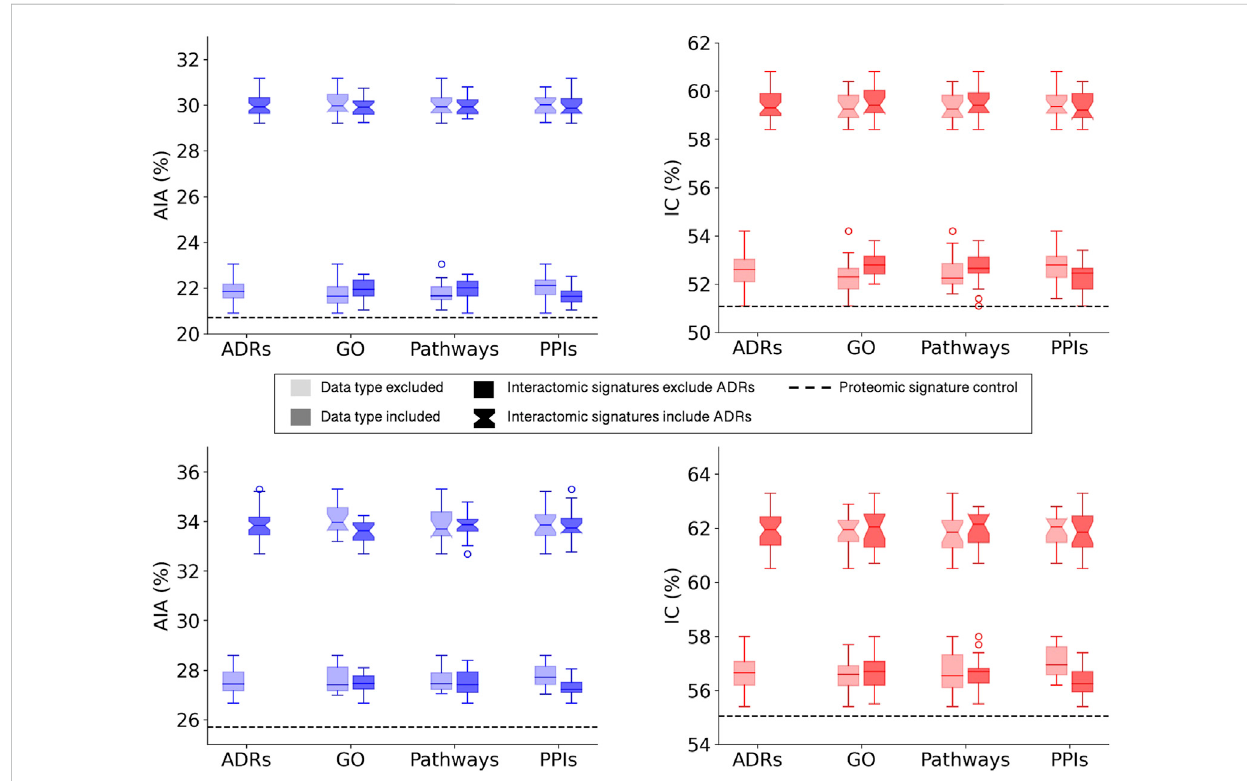
FIGURE 2 Benchmarking performance of CANDO interactomic signatures with various biomedical data. The difference in benchmarking performance when including or excluding certain biomedical data sources in the multiscale networks, namely, adverse drug reactions (ADRs), Gene Ontology (GO) annotations,proteinpathways,andprotein-proteininteractions(PPIs),isdepictedforthefulldruglibrary(top).Bothaverageindicationaccuracy(AIA)and indication coverage(IC)followedthesameoveralltrendinwhichnetworksthatincludedADRs(notchedboxplots)farexceededtheperformanceof networksthatexcludedADRs(squareboxplots).Thistrendwasnotobservedfortheremainingdatatypesinregardstotheirinclusion(darker)orexclusion (lighter) from the networks. However, all interactomic signatures far exceeded the proteomic signatures control (dashed black line) in performance regardless of the presence of ADRs, indicating the multiscale networks were still accurately capturing drug behavior. The above analysis was repeated withasublibraryof1,047drugsthathadatleastoneADRassociatedfromSIDERandOFFSIDES(bottom).Similarresultswereobservedwiththissublibrary for both average indication accuracy (left) and indication coverage (right), suggesting it is not merely a bias of network architecture. The signi fi cant disparity between the performance with and without ADRs implied that ADRs provided rich biological signal for describing drug behavior and motivated us to predict ADRs for all small molecule compounds in the